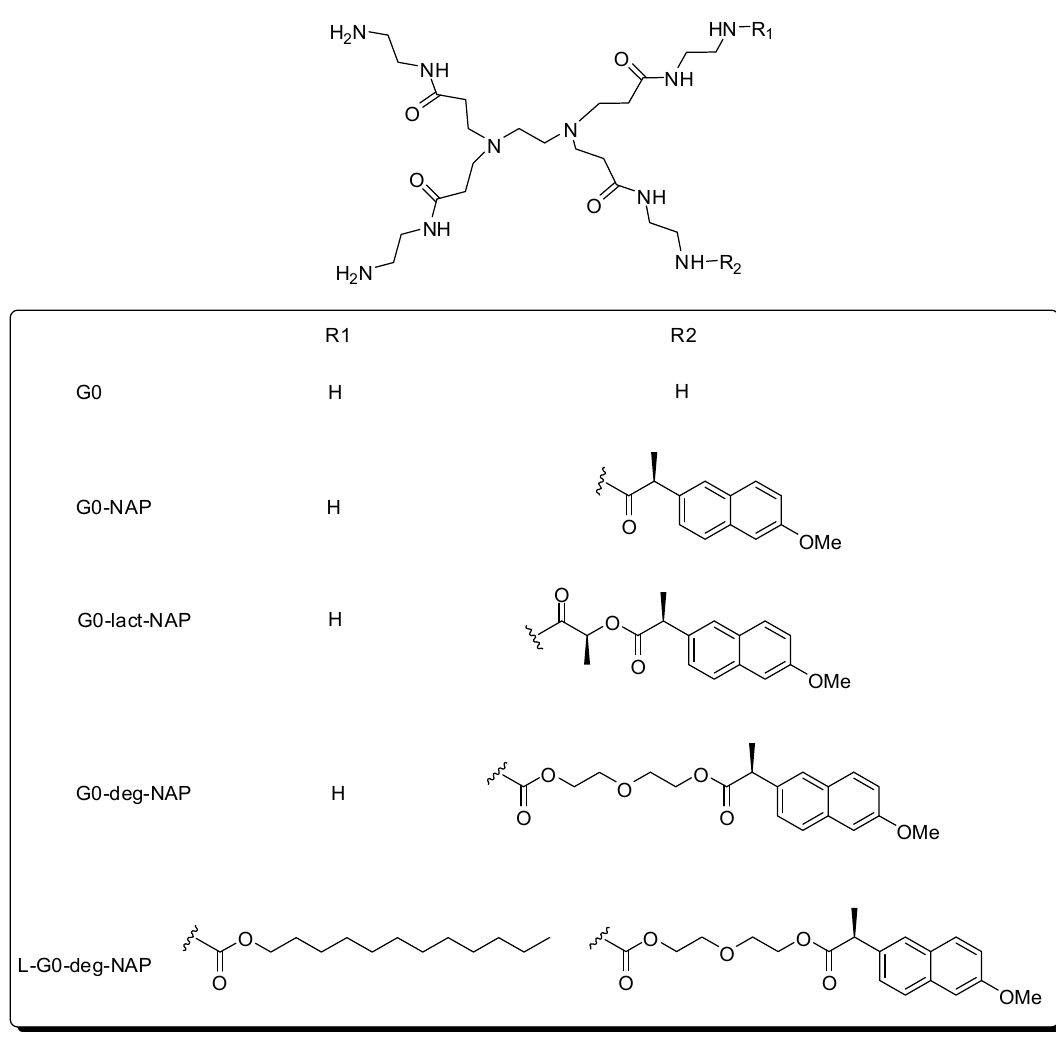
Figure 6. Dendrimer prodrugs containing naproxen [37].